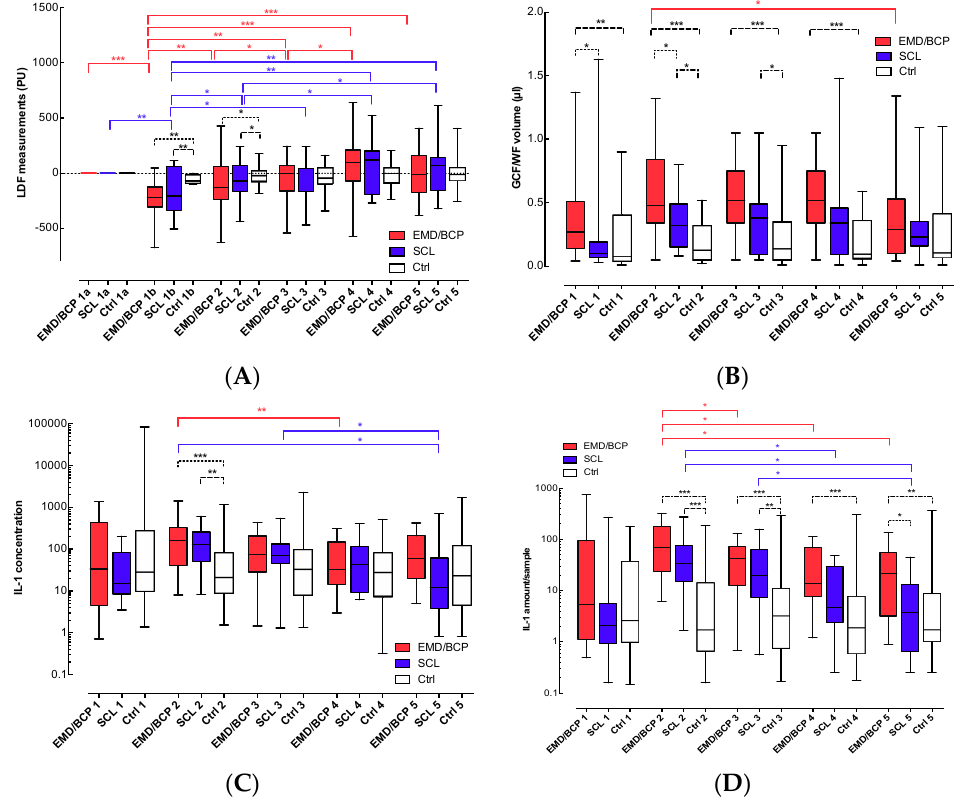
Figure 1. ( A ) LDF measurements of microcirculation; ( B ) Measurements of GCF/WF volume; ( C ) Concentration of IL-1 β in GCF/WF samples; and ( D ) Total amount of IL-1 β in GCF/WF samples. EMD/BCP (enamel matrix derivative/biphasic calcium phosphate): red, SCL (surgical crown lengthening): blue, Ctrl (control): white; LDF: laser Doppler flowmetry; GCF/WF: gingival crevicular fluid/wound fluid; IL-1: Interleukin 1 ; *: p < 0.05; **: p < 0.01, ***: p < 0.001.